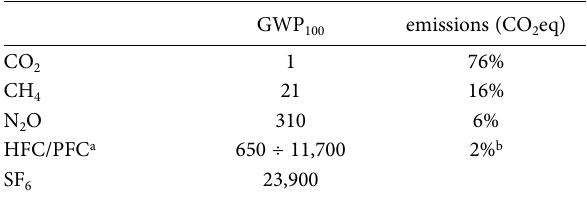
Table 1. Contribution of each gas to global GHG emissions, rela- tive to CO 2 , based on the amount of gas emitted and on the relative global warming potential (GWP 100 ). GWP 100